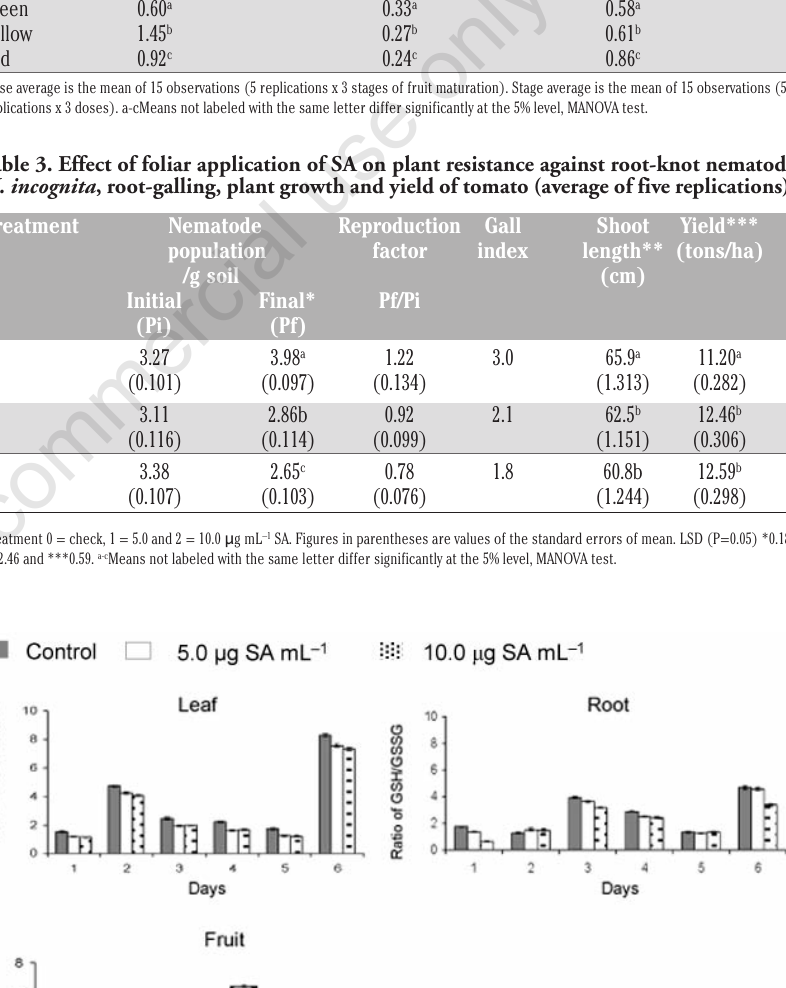
Figure 3. Effect of salicylic acid (SA) on redox status of tomato during crop growth and fruit maturation (days 1 = 0, 2 = 15, 3 = 30, 4 = 60, 5 = 90 and 6 = 120 days after applica- tion; stage 1 = green, 2 = yellow and 3 = red